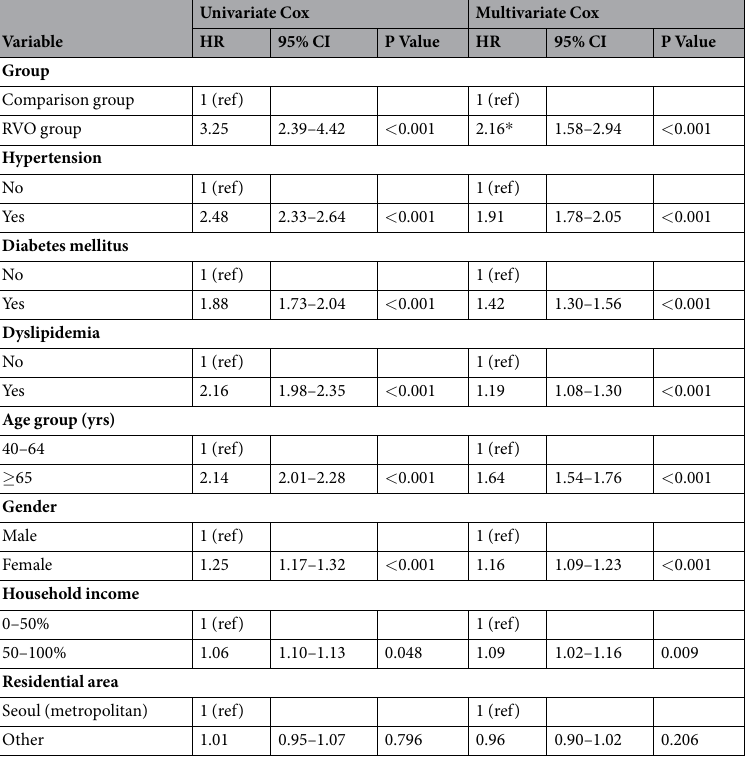
Table 2. Univariate and multivariate cox regression analysis for development of primary open angle glaucoma after retinal vein occlusion during an eleven-year follow-up period. RVO = retinal vein occlusion, HR = hazard ratio, CI = confidence intervals. * Adjusted for age, gender, income, residential area, hypertension, diabetes mellitus, dyslipidemia.